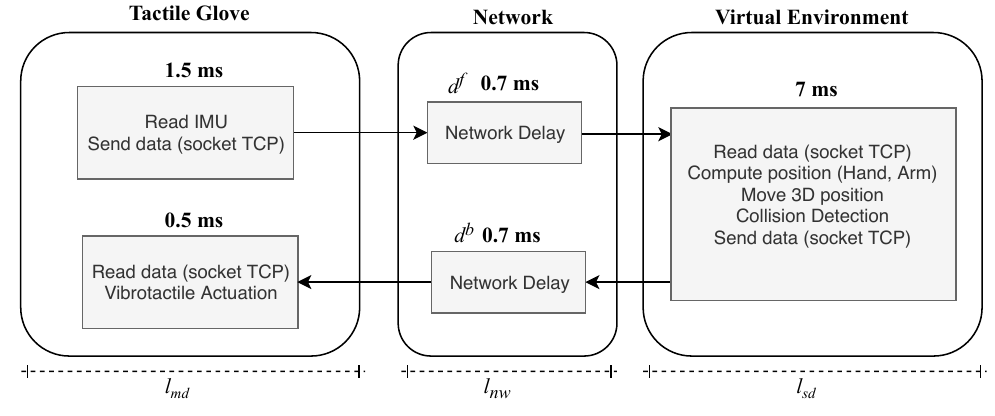
Figure 8. Component latencies. Round trip latency is 10.4